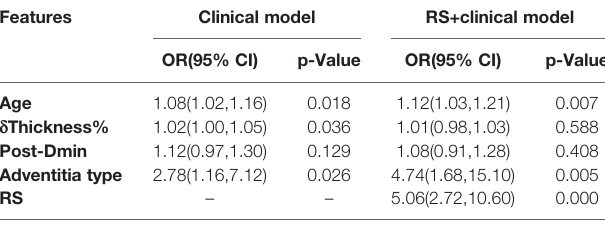
TABLE 2 | Two prediction models for pCR using multivariate logistic